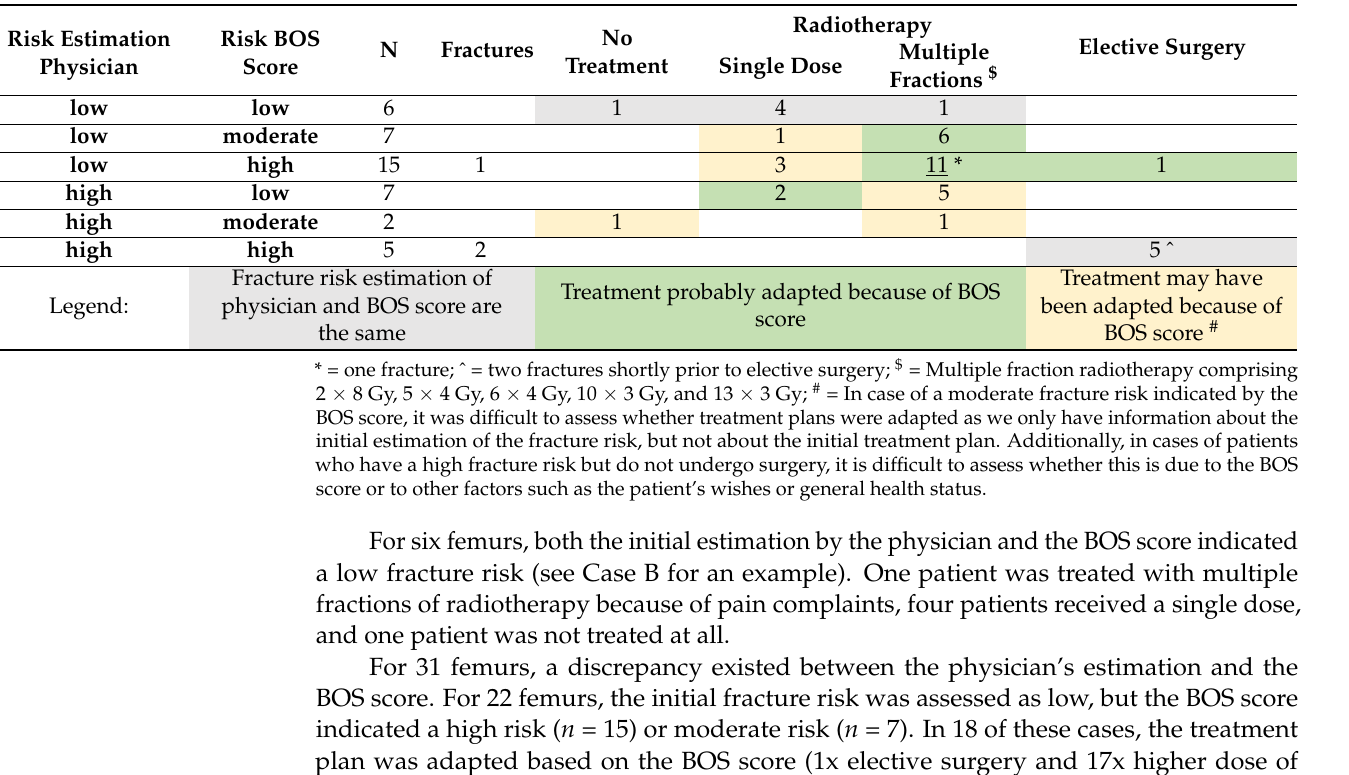
Table 2. Fracture risk estimations by physician and based on BOS score, and the subsequent treatment